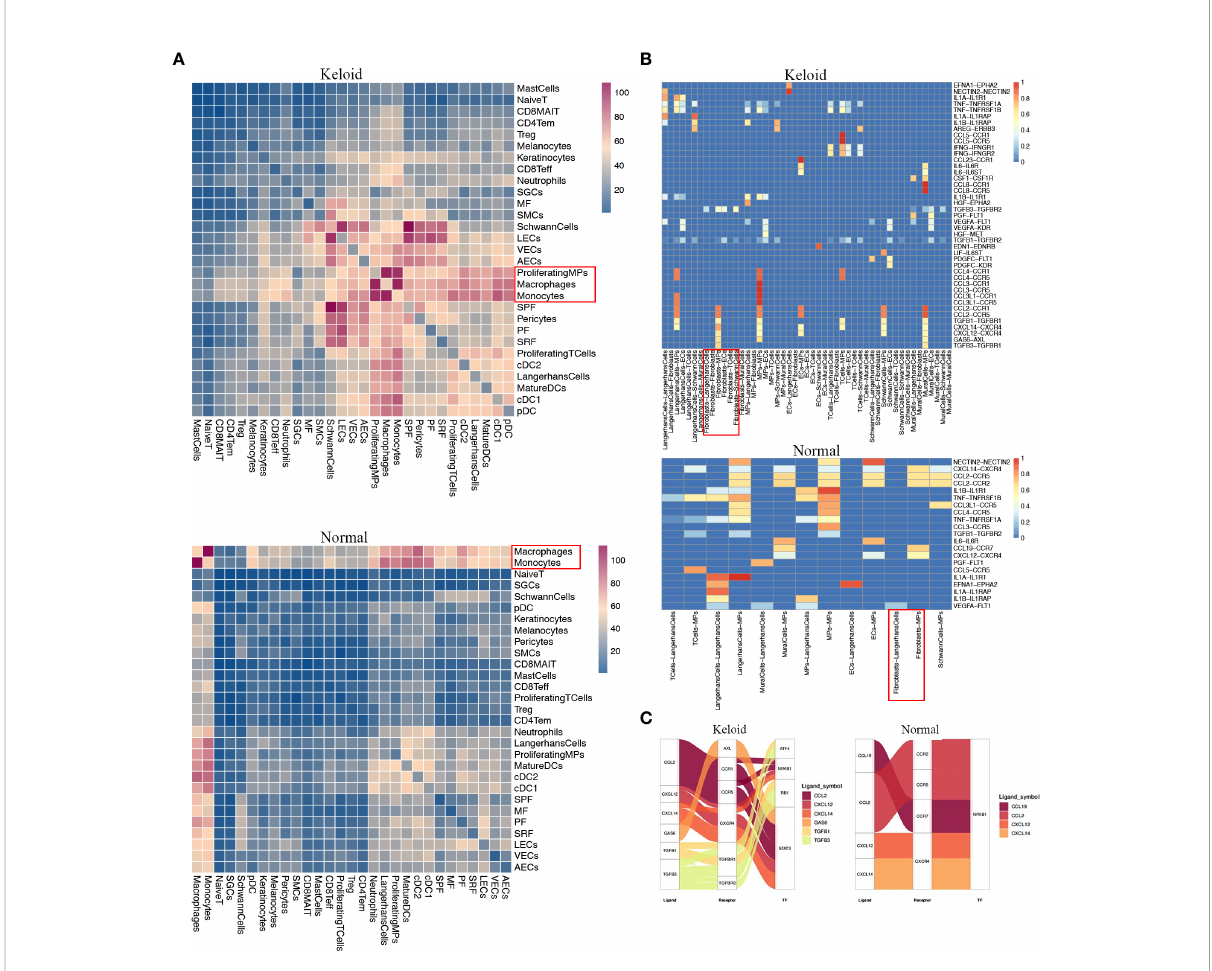
FIGURE 6 Potential ligand – receptor interactions analysis in fi broblast subpopulations. (A) Heatmap showing the numbers of interpopulation communications with each other in keloid and adjacent normal tissue. (B) The ligand – receptor pairs exhibit signi fi cant changes in speci fi city between any one of the populations and any one type of fi broblast in adjacent normal tissue versus keloid. (C) Putative and relative signaling or transcriptional factors (TFs) within fi broblasts and other cell populations ’ keloid and adjacent normal